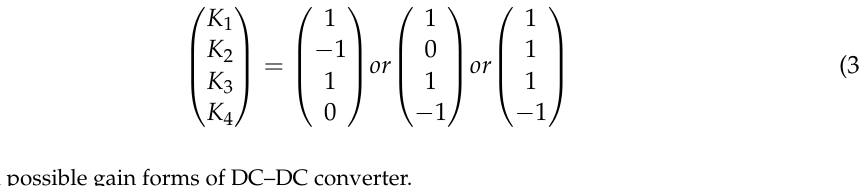
Table 1. All possible gain forms of DC–DC